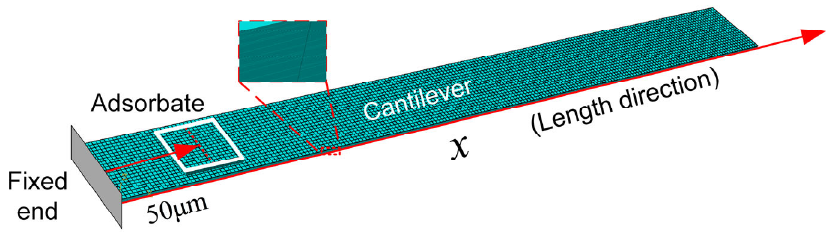
Figure 7. The FEA model of the cantilever resonator and adsorbate.